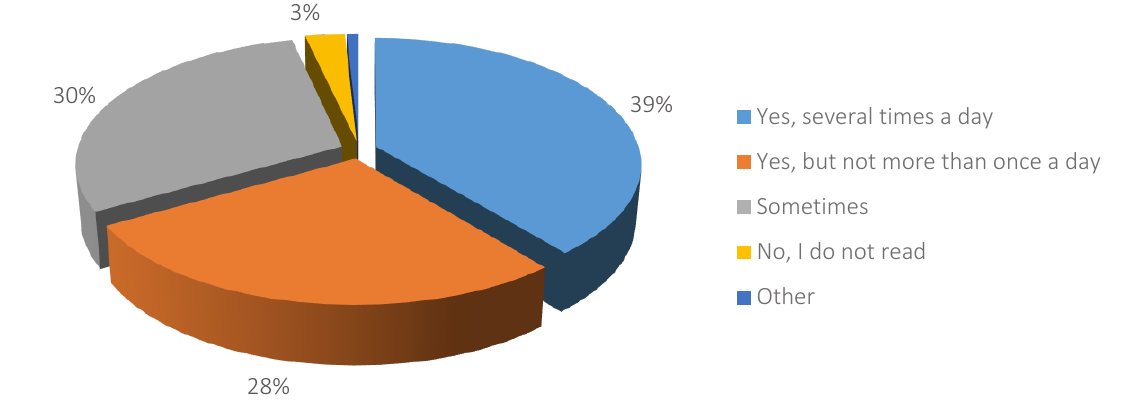
Figure 1. Interest of young Ukrainians in consuming news before СOVID-19